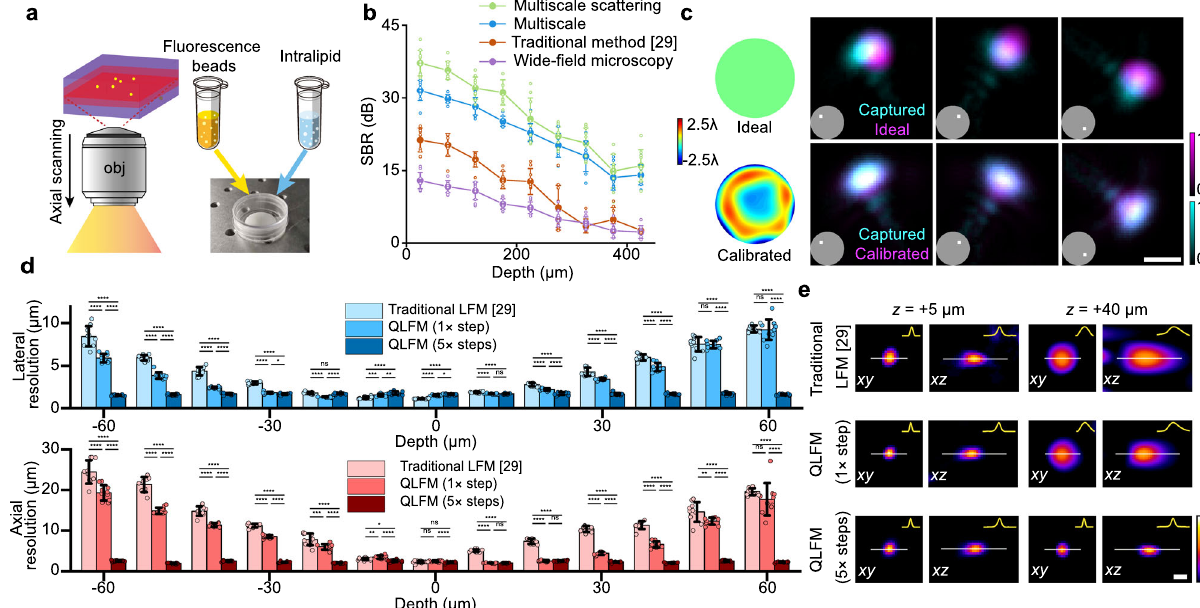
Fig. 2 Characterization of quantitative light- fi eld microscopy (QLFM). a Illustrations of the SBR characterization experiment. We fabricated the scattering phantom with the mixture of 0.025% 2- μ m fl uorescence beads, 1% intralipid, and 1% agarose in a petri dish. Then we imaged the sample with a